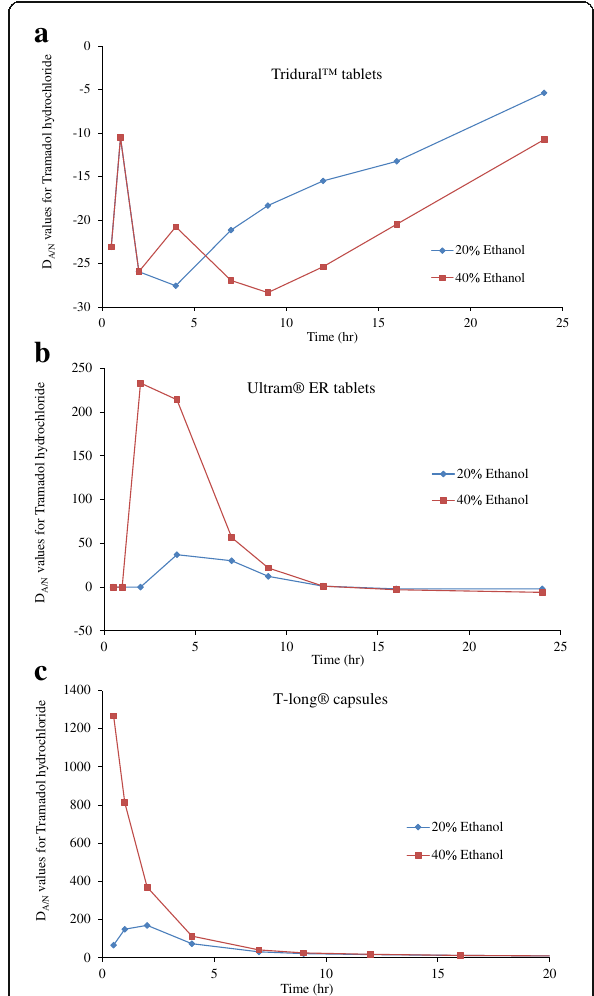
Fig. 9 The effect of ethanol concentration on the D A/N values of tramadol hydrochloride for three different formulations. (data from reference (Traynor et al. 2008))